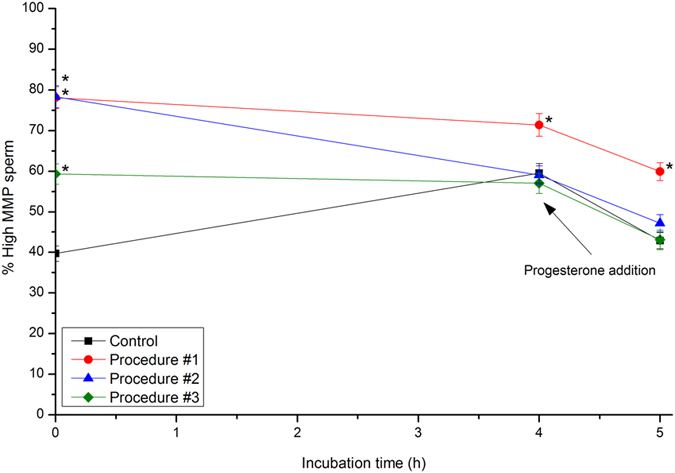
Percentages of sperm with high mitochondrial membrane potential (MMP; JC-1+).Boar sperm were subjected to separate photo-stimulation procedures and the subsequent IVC/IVAE as described in the Methods section. 0: values at 0 h of incubation in the capacitation medium (CM). 4: values at 4 h of incubation in the CM. 5: values after 4 h IVC plus 60 min of the progesterone-induced IVAE. Results are shown as mean ± SEM for 12 separate experiments. Asterisks indicate significant (P < 0.05) differences when compared with the respective Control value at the same time point.